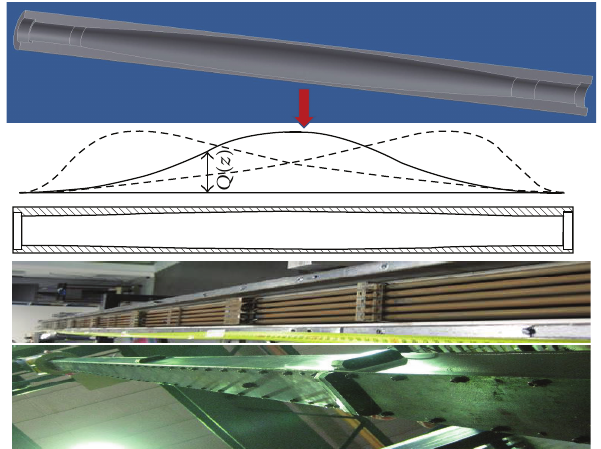
Figure 2: Rod bundle CHF with nonuniform axial power distribu-